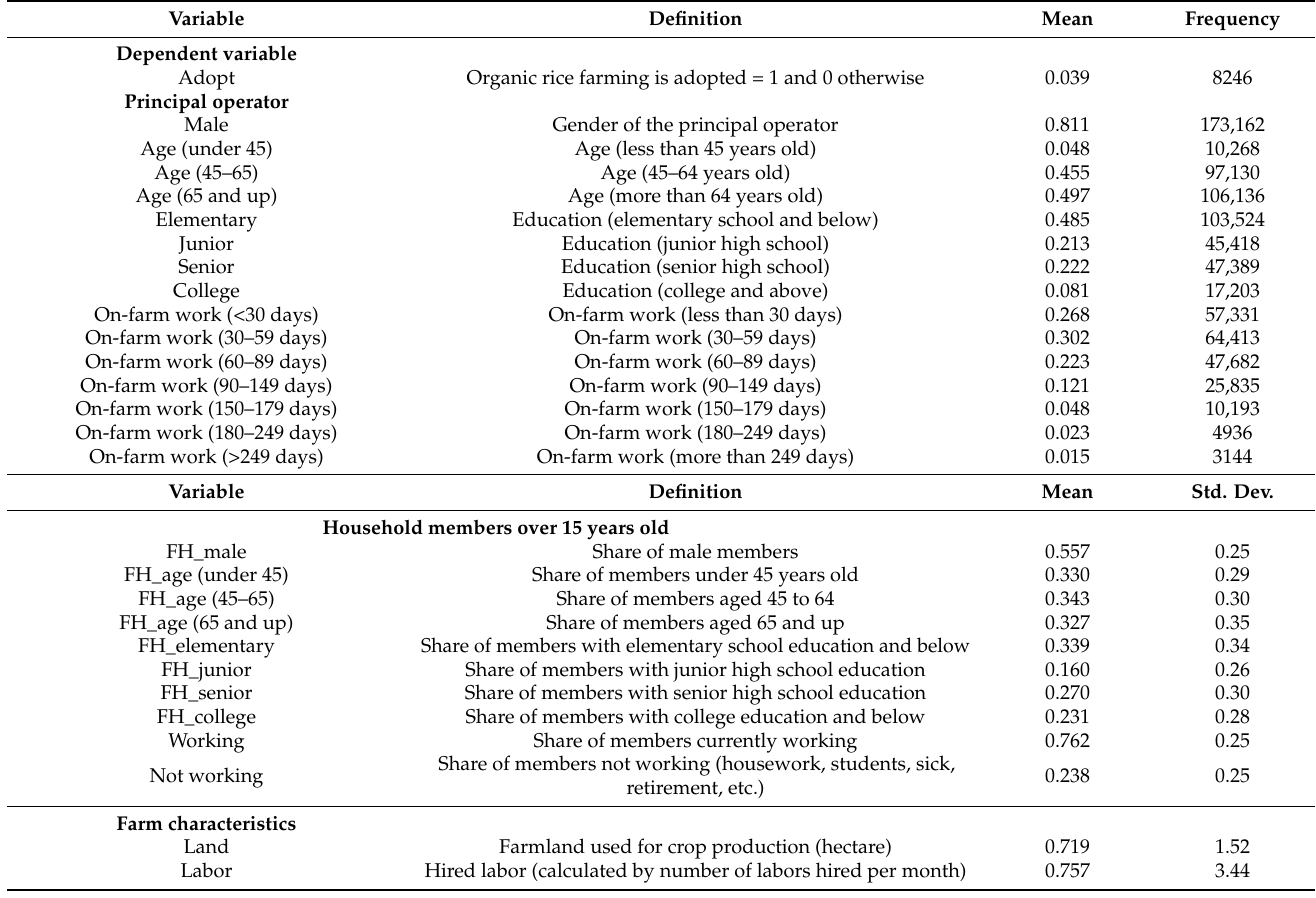
Table 1. Definition and descriptive